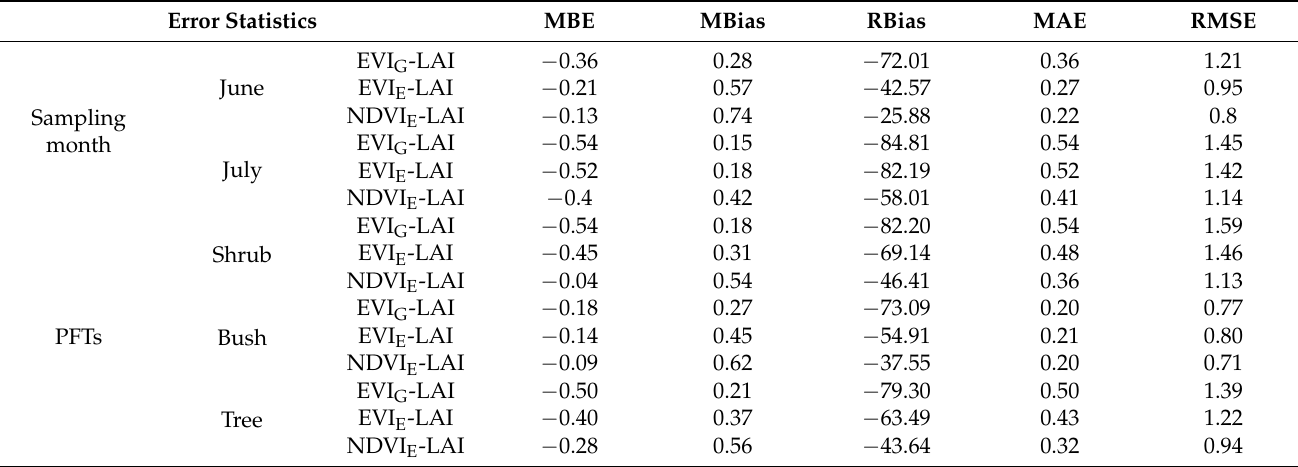
Table 7. Results of accuracy assessment for each study month and